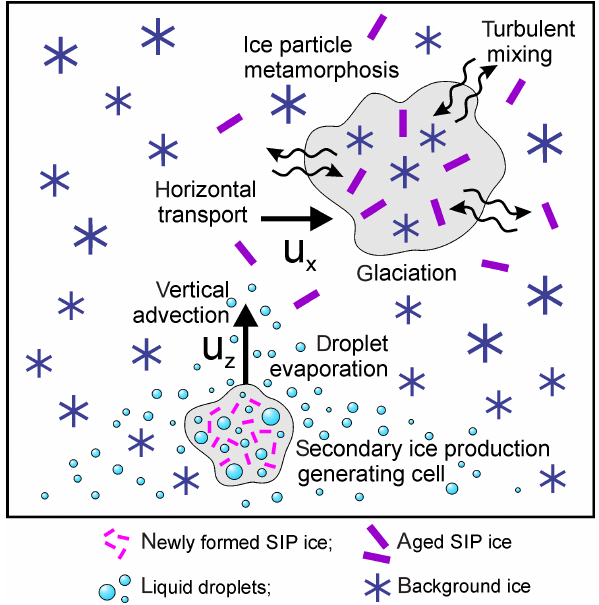
Figure 1. Conceptual diagram of the transport of secondary ice pro- duction particles in a cloud after its